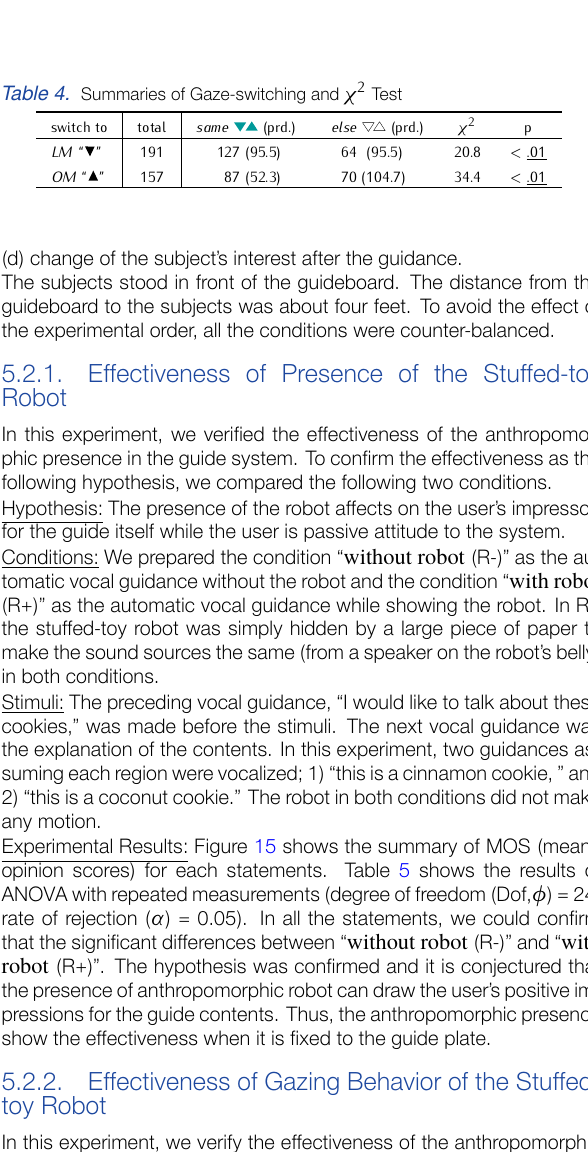
Figure 13. Relation of Robot’s and Subject’s Gazes